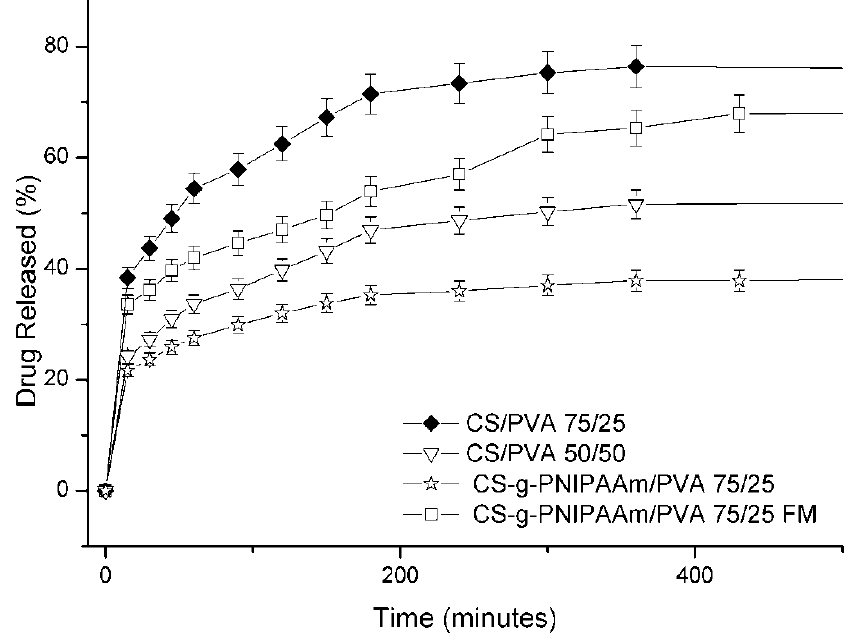
ff erent types of gel